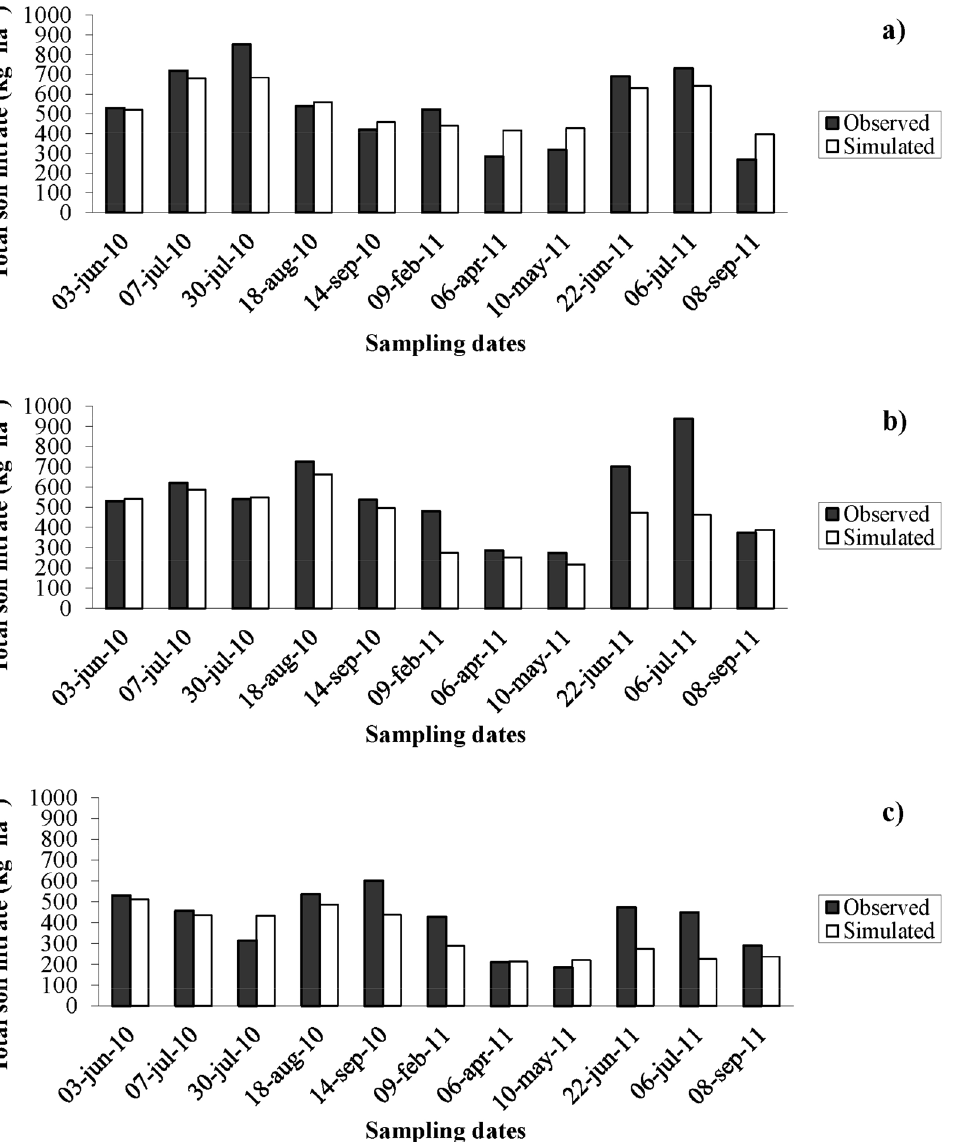
Fig 2. Observed and simulated soil profile nitrate content. Observed (filled bars) and simulated (open bars) soil profile nitrate (NO3-) content during the maize-triticale-maize rotation for the NMIN (a), CONV (b) and N0 (c)